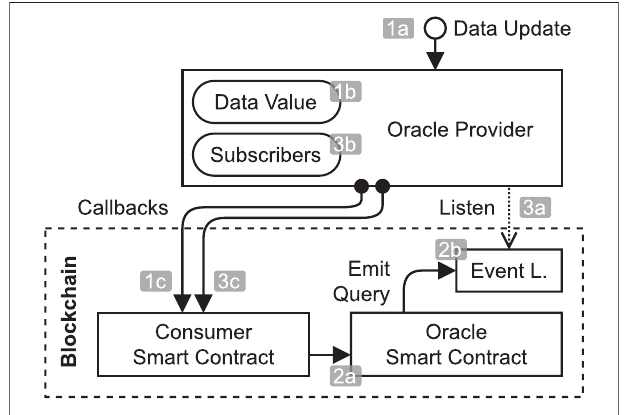
FIGURE 5 | Architecture and behavior of the publish-subscribe